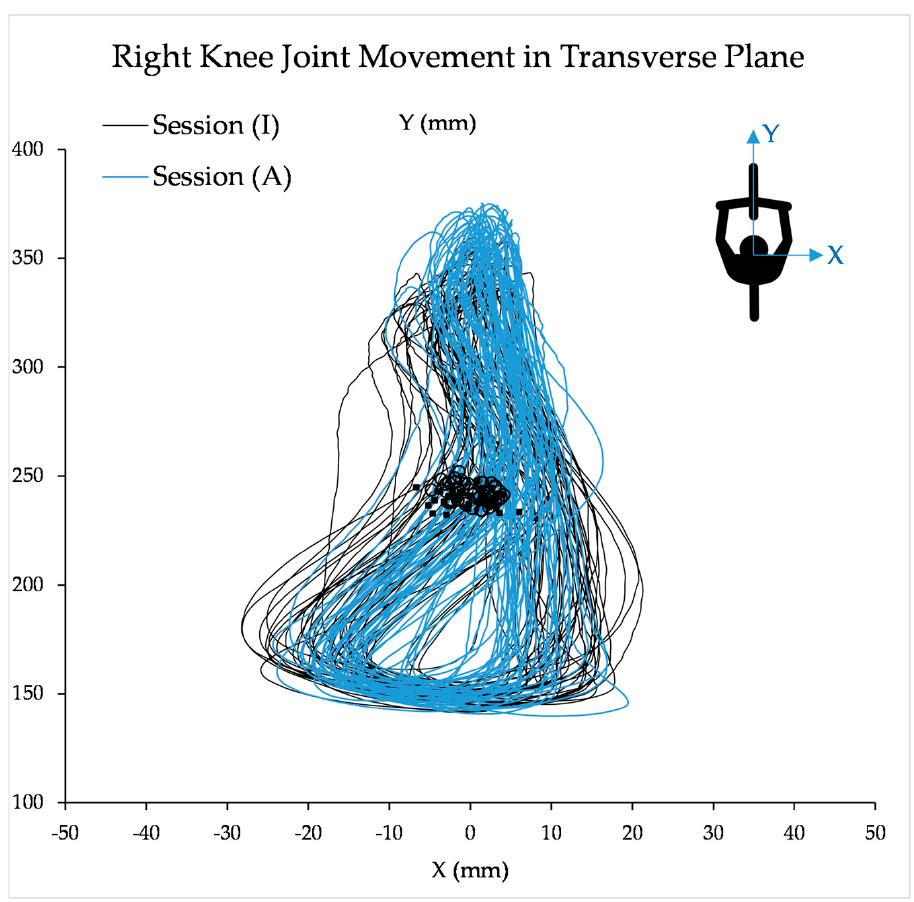
Figure 5. The lateral-medial movement of the target knee joint marker in the transverse plane was captured by the motion capture system, when APAD was inactive (I) and active (A). The square ( ■ ) and circle ( ○ ) markers represent the center point of the knee joint position during a full cycle for sessions (I) and (A) in Trial 1, respectively. The result is for a representative participant.